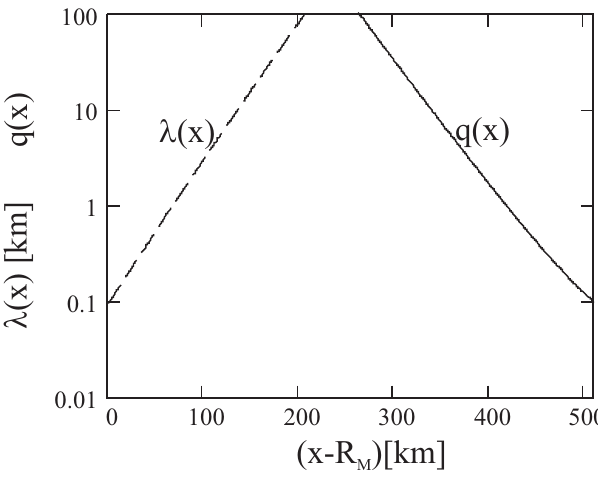
Fig. 1b. Collision free path λ(x) (dash line), and the dimensionless mass loading parameter q(x) (solid